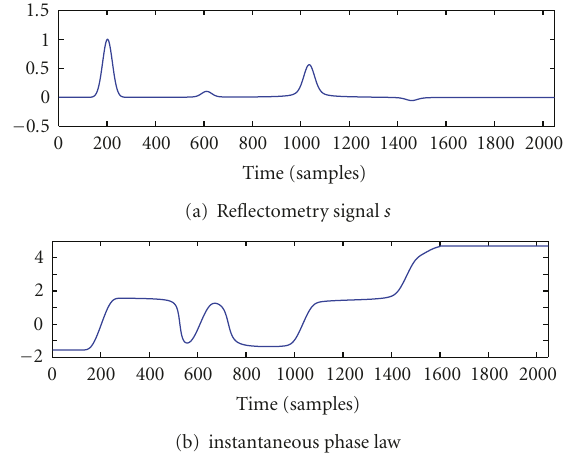
Figure 15: (a) Reflectometry signal s ; (b) instantaneous phase law of the analytic signal associated to s